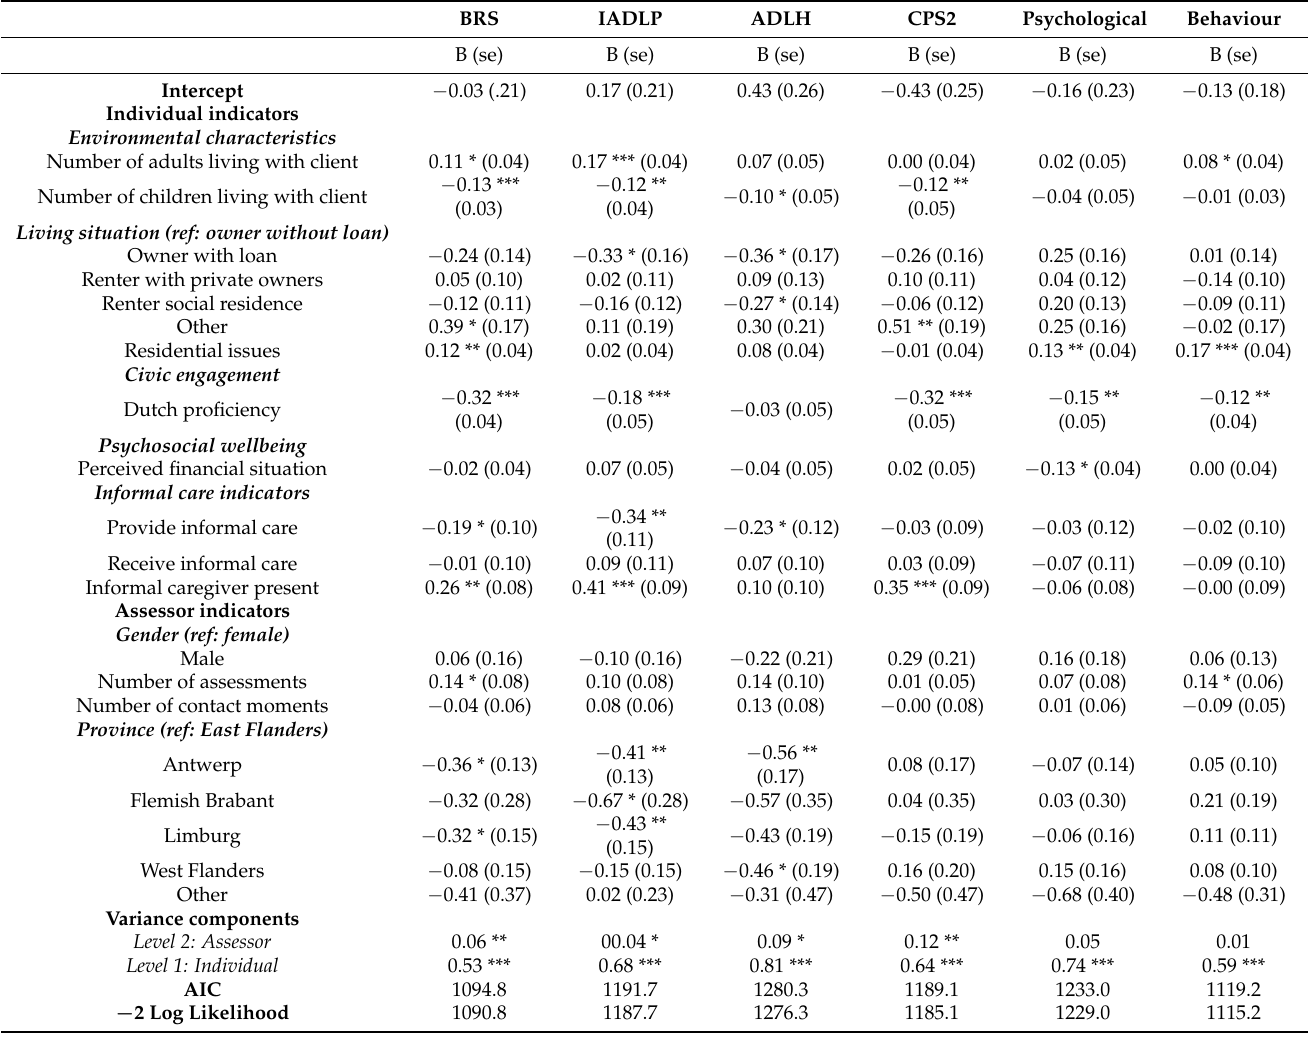
Table A4. Multilevel regression analyses of client- and assessor-level variables on assessment scores for assessors with 10 clients or